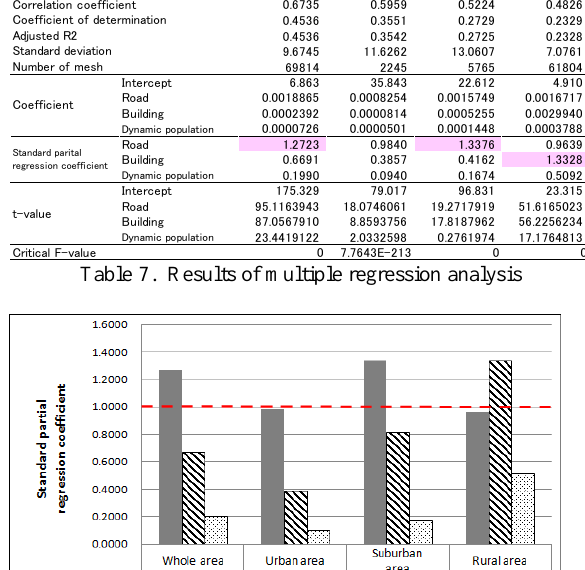
around cities like toroidal